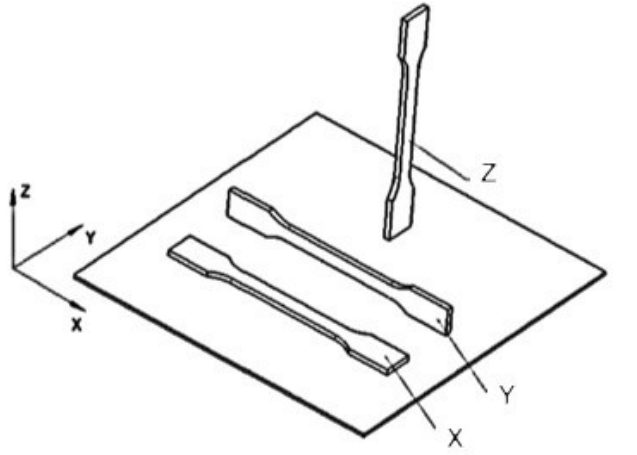
Figure 1. The orientation of manufactured tensile test specimens during the 3D printing process. The printing parameters of all samples are provided in Table 1. Apart from the variation in printing direction, the rest of the printing parameters were kept the same. The infill density was set to 100% (solid) for all samples and the samples were printed without a border. The dimensions of the test specimens for the tensile tests were 100 × 10 × 3 mm 3 according to the standard [26]. Five samples for each printing direction and cooling regime were manufactured. The dimensions of the samples for dynamic mechanical testing were 30 × 3 × 1 mm 3 . Three replicants were tested to obtain statistically confident values. Thus, the values provided on the graphs correspond to the mean value together with the standard deviation. Table 1. Printing